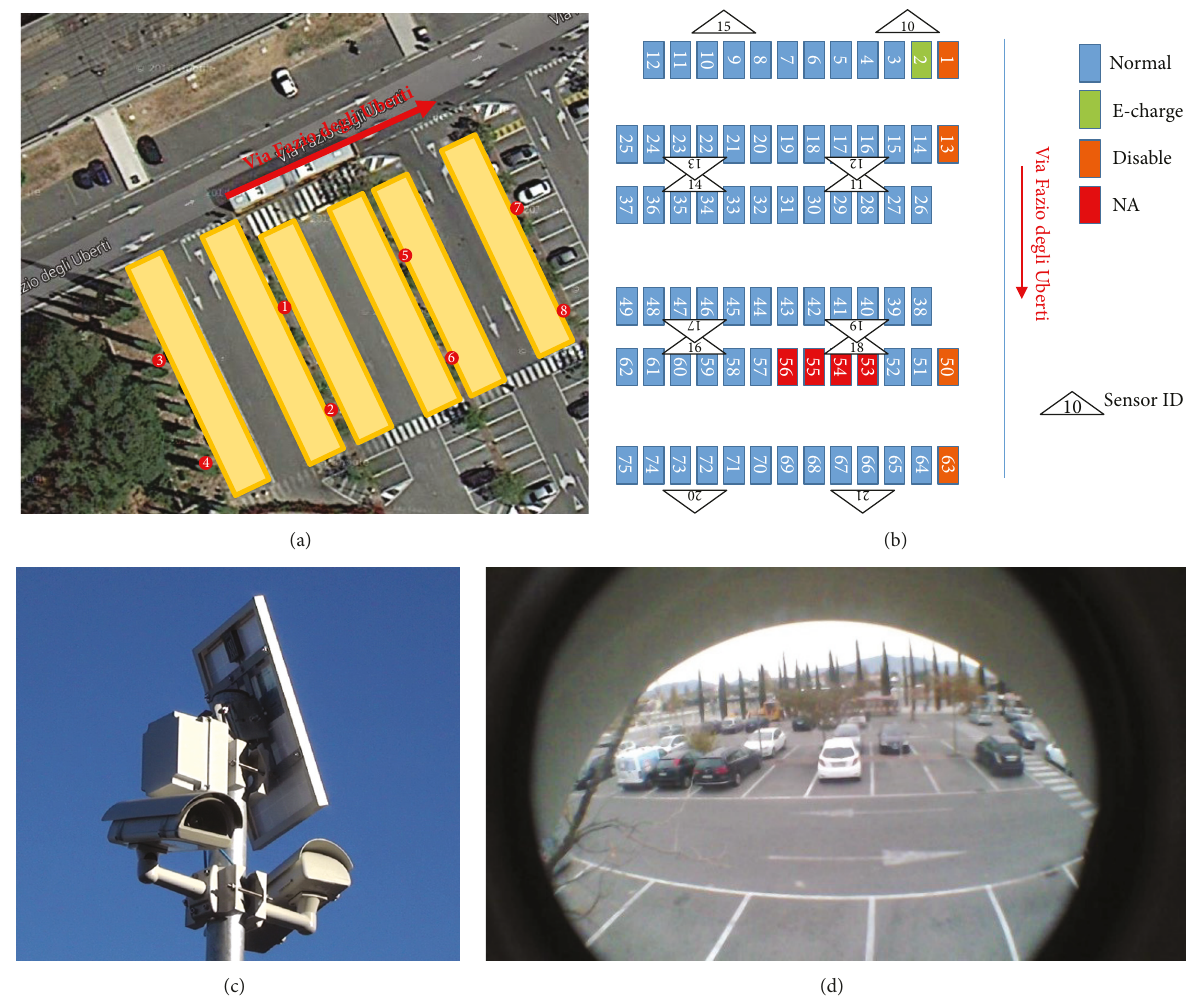
Figure 10: Results: (a) pole displacements for sensor installation, (b) schema of parking lot monitoring with sensor and spaces IDs, (c) example of installation of two sensors on a single pole, and (d) parking view from sensor ID =